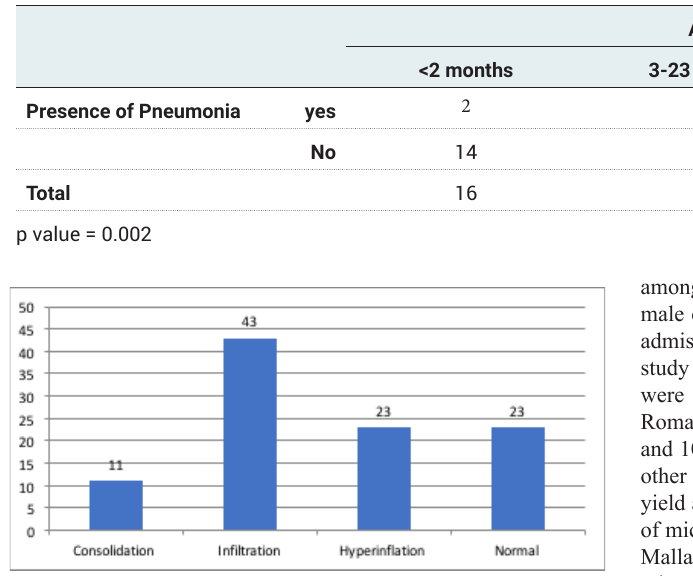
Table 2B: Prevalence of pneumonia with age